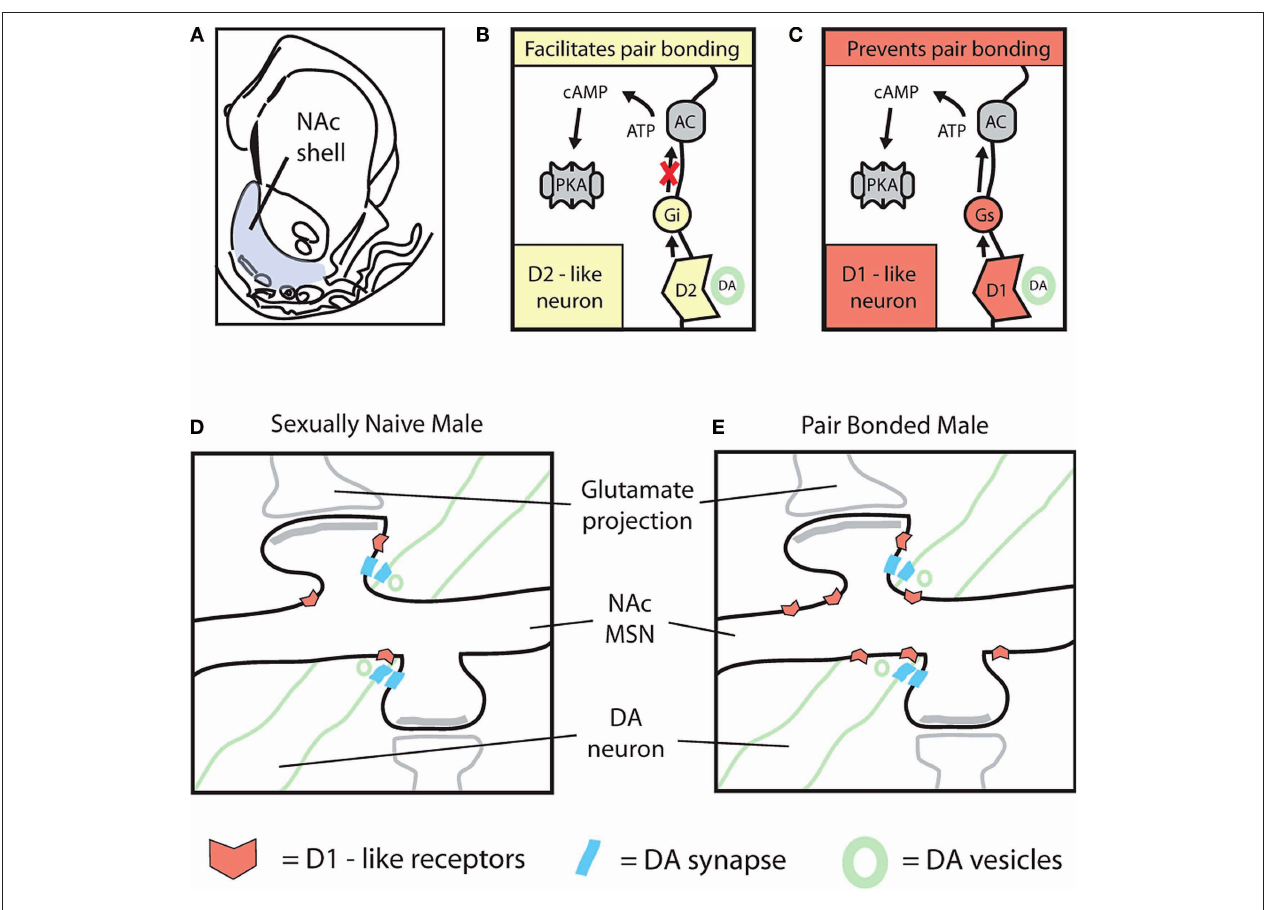
FIGURE 6 | Differential regulation of pair bond formation and maintenance by dopamine transmission within the NAc. (A) Cartoon based on (Arbuthnott and Wickens, 2007) showing the portion of the NAc shell where DA manipulations effect pair bond formation. (B) Diagram of D2-like signaling pathway involved in partner preference formation. (C) Diagram of D1-like